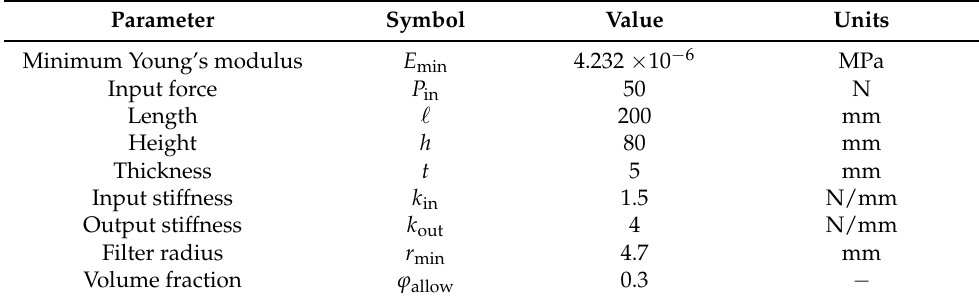
Figure 2. Example definition scheme for maximum output displacement gripper (gray: design space, black: non-design space of solid material, white: non-design space of voids). Table 2. Parameters specific for maximum displacement example